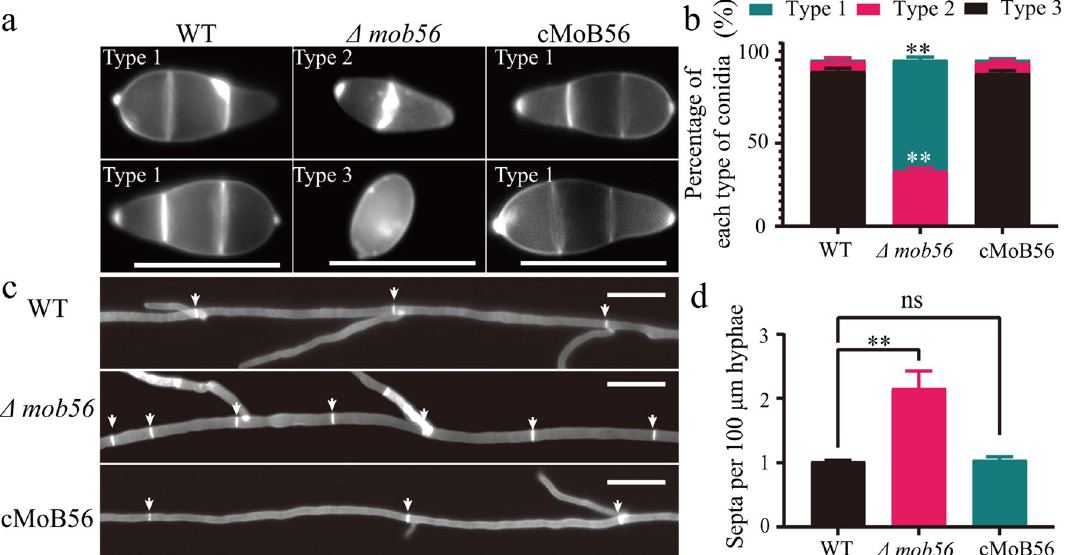
Fig. 3 MoB56 regulates conidium morphology and septation in Magnaporthe oryzae . a Conida of the Δmob56 deletion mutant and the complementary strain cMoB56 were stained with Calcofluor white (CFW) and examined by epifluorescence microscopy. Bars Percentage of different types of conidia generated by the indicated strains. Error bars represent were stained with CFW and examined by epifluorescence microscopy. Bars hyphae in the indicated strains. Error bars represent